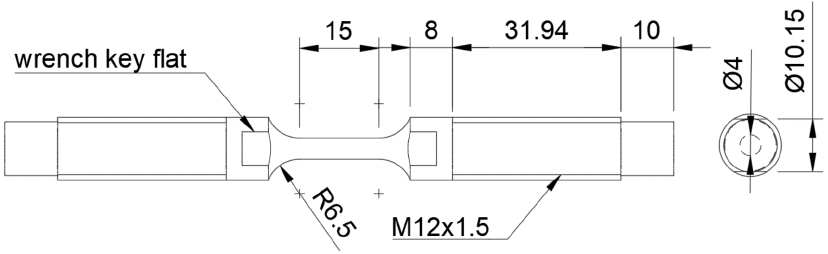
Figure 1. Specimen geometry with cylindrical gauge region of (cid:31) 4 × 15. All dimensions are in